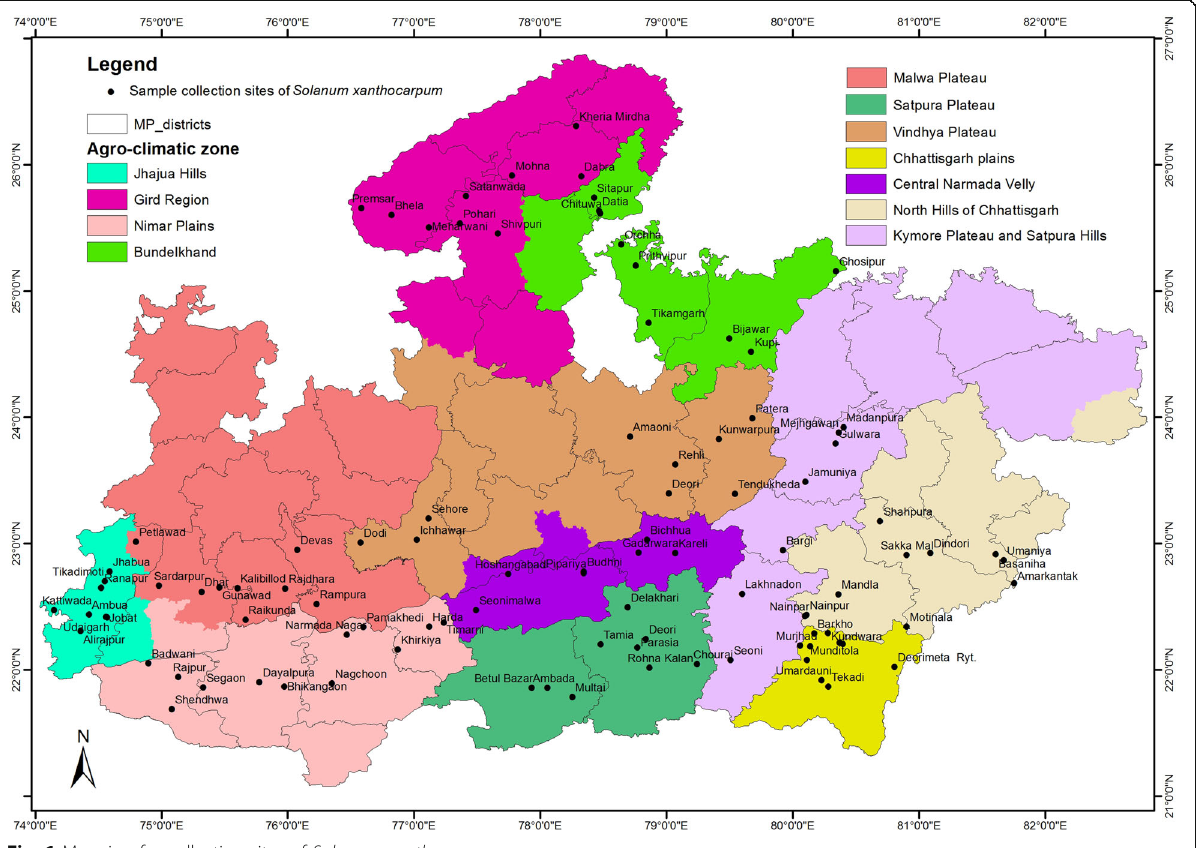
Fig. 1 Mapping for collection sites of Solanum